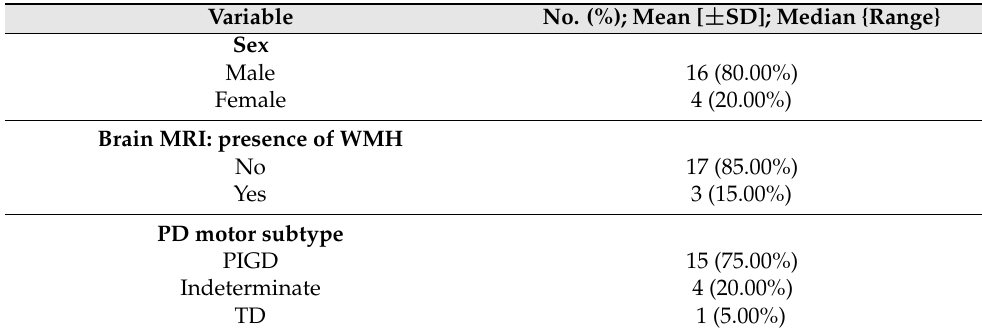
Table A1. Pre-operative demographic and clinical